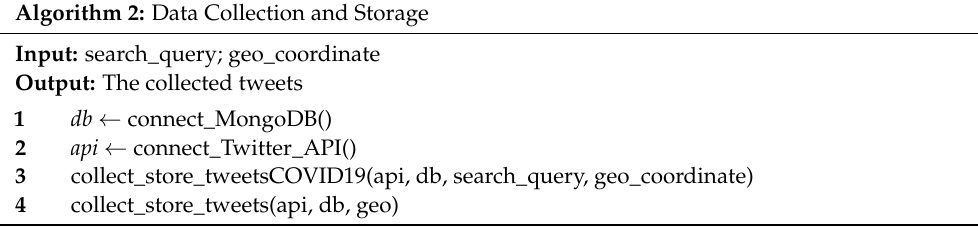
Algorithm 2: Data Collection and